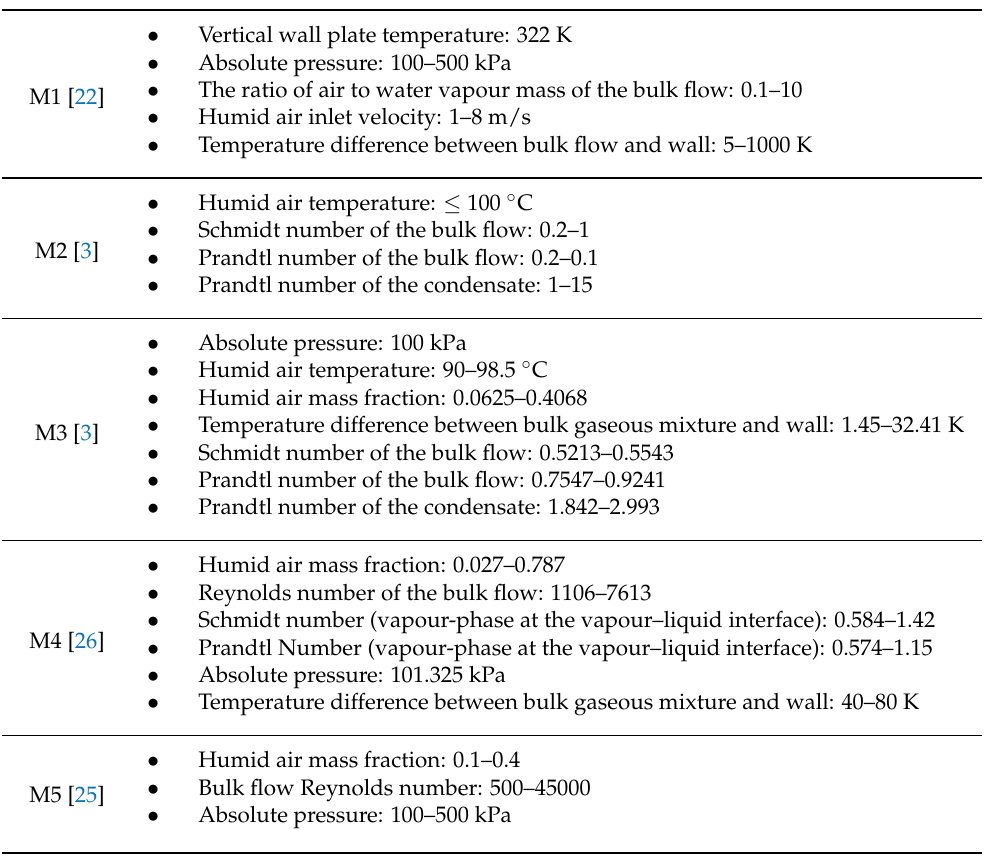
Table A2. Application range of existing semi-empirical correlations